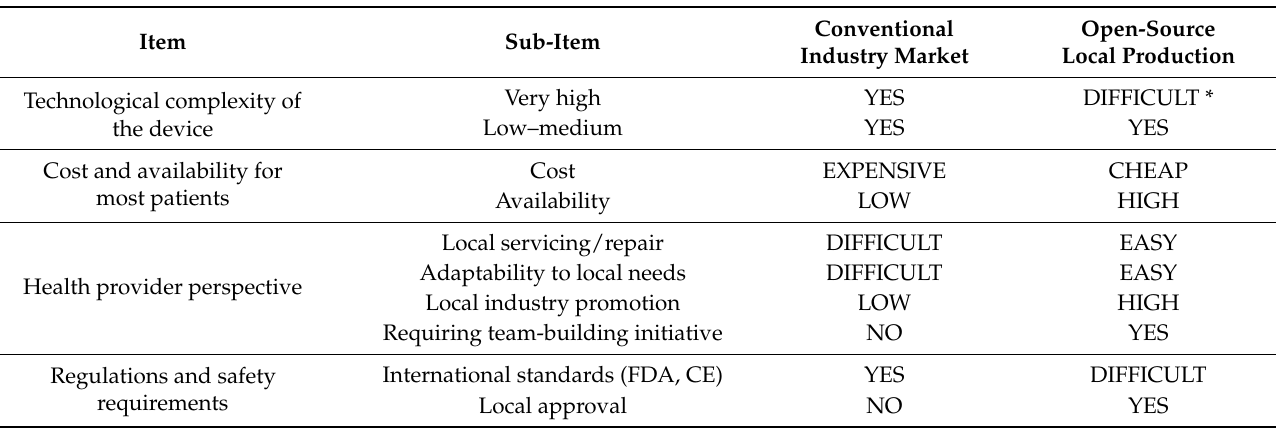
Table 1. Summary of the main features of medical devices from the conventional industry market and from open-source local